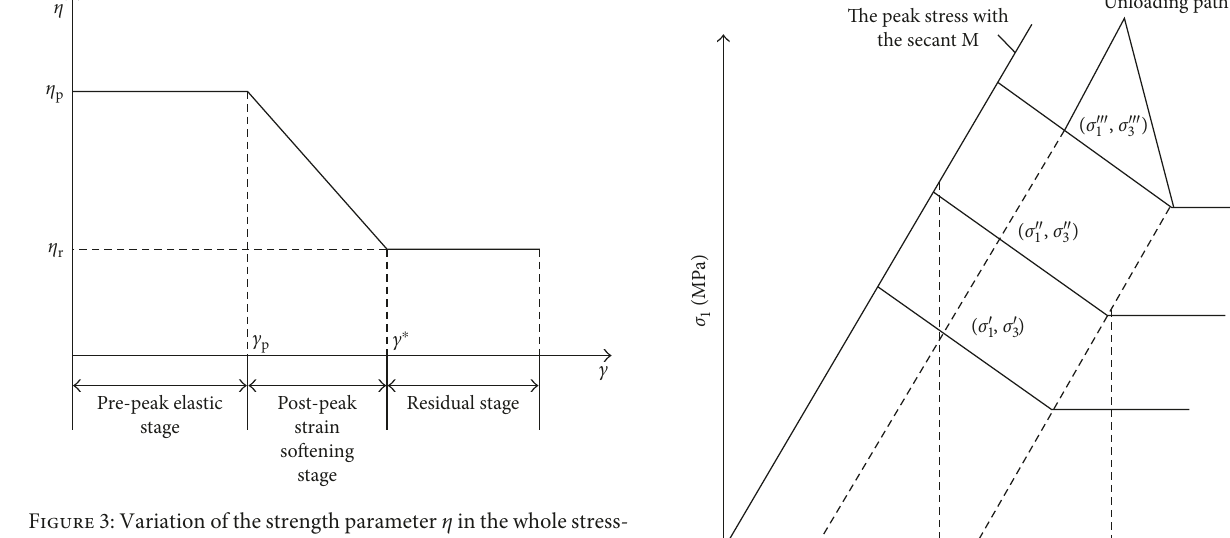
Figure 3: Variation of the strength parameter η in the whole stress- strain curve.